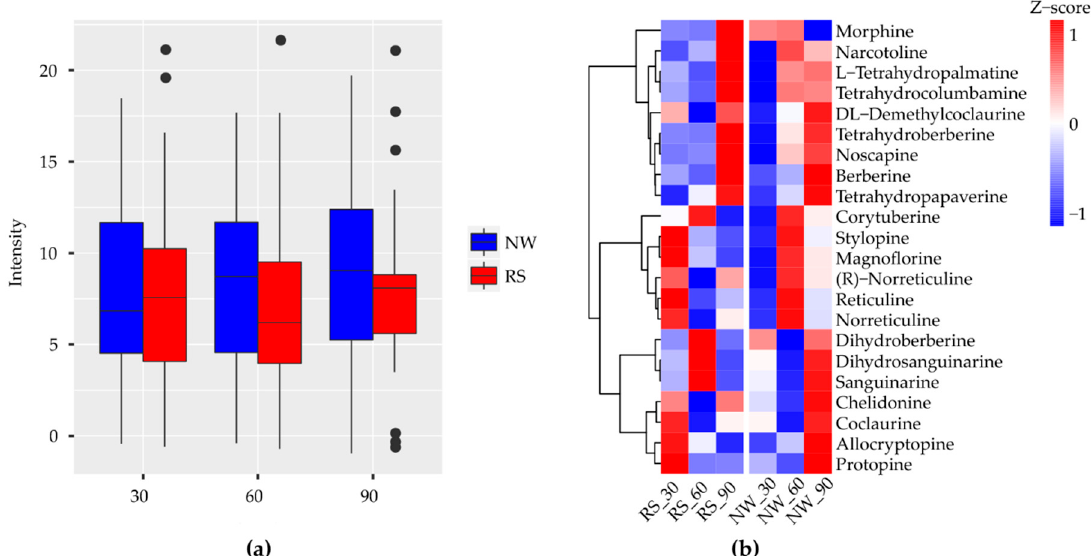
Figure 7. The quantification of alkaloids observed from the target metabolite analysis; ( a ) the total alkaloid content assessed from the Papaver plant developmental stages; ( b ) The detail expression of individual metabolites with respect to Papaver spp. developmental stages, which used to derive the total metabolite quantifications and these metabolites were mapped to the BIA KEGG reference map (Figure 6).